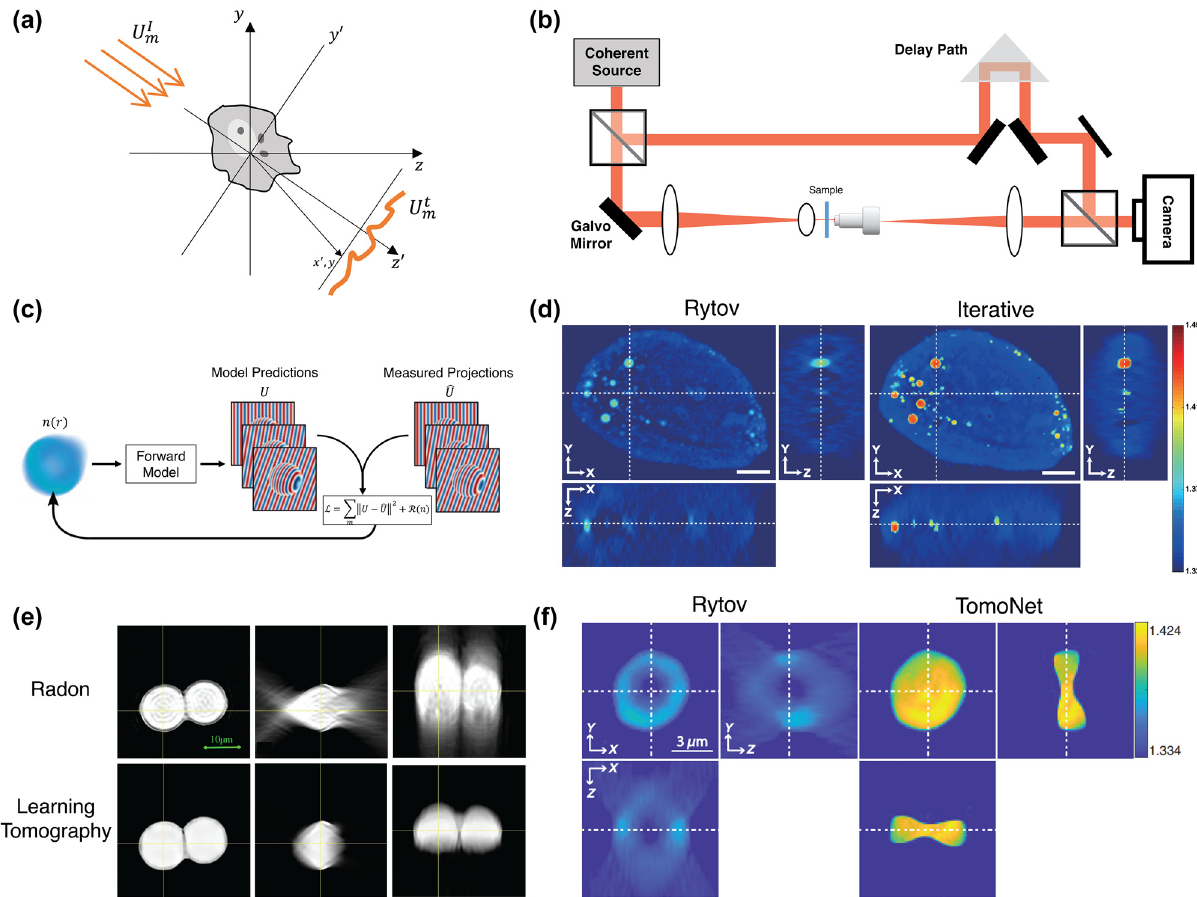
Figure 1: Optical tomography. (a) An overview of the optical tomography problem. A 3D object is illuminated with different plane waves, and 2D quantitative phase projections are measured for each illumination angle. (b) A standard off-axis holography setup for refractive index tomography. The illumination angle can be controlled using a pair of galvo mirrors. (c) Iterative optical diffraction tomography (ODT): A forward model (such as single-scattering [23] or beam propagation method [24] computes the 2D projections for each illumination angle. By comparing this field to the measurements, a loss function is calculated, which is minimized by improving the reconstruction of the 3D refractive index iteratively. (d) Comparison of ODT reconstruction results for a hepatocyte cell using the Rytov approximation and iterative ODT with edge-preserving regularization (Adapted from [23] Copyright OPTICA). The scale bar is 5 μ m. (e) Tomographic results of two 10 μ m polystyrene beads immersed in oil with n inverse Radon transform and learning tomography (Adapted from [24], Copyright OPTICA). (f) 3D reconstruction of a red blood cell using TomoNet. (Adapted from [28] Copyright SPIE). Figures (e) and (f) show that learning tomography and TomoNet solve underestimation and elongation of the